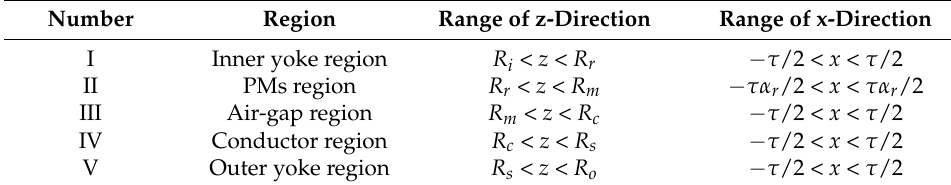
Table 1. The divided regions.